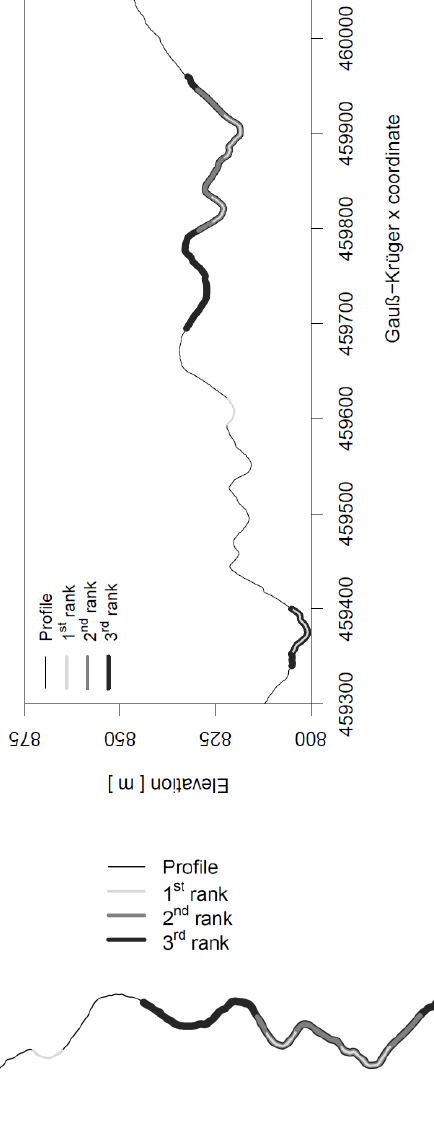
Figure 2. Representation of sinkhole rank on a profile of the ground surface (top) with detail